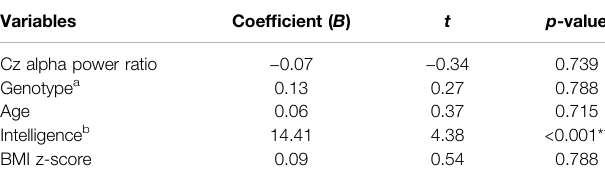
TABLE 4 | Multivariate stepwise linear regression analysis coef fi cients of the association between the omission error T-score and attention-to-resting Cz alpha power